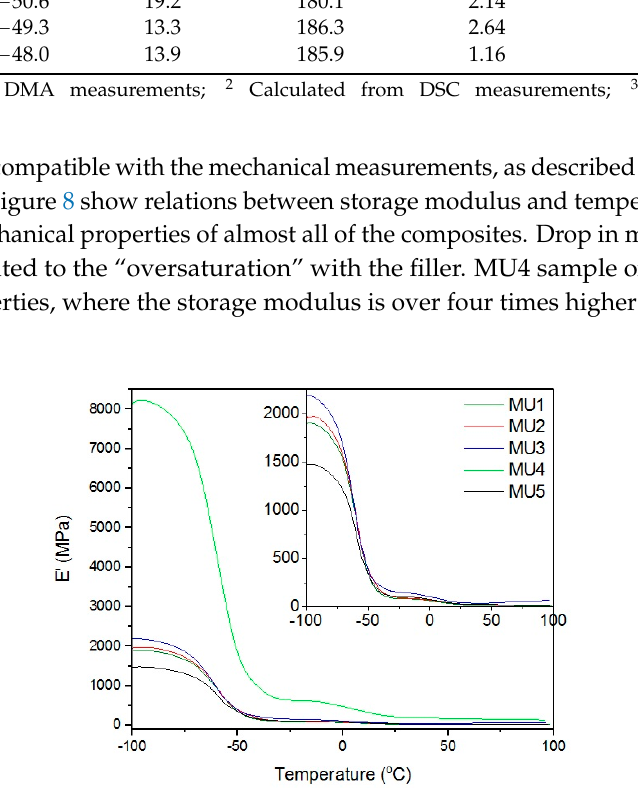
Table 3. Results of thermal properties from DSC, DMA and TGA.